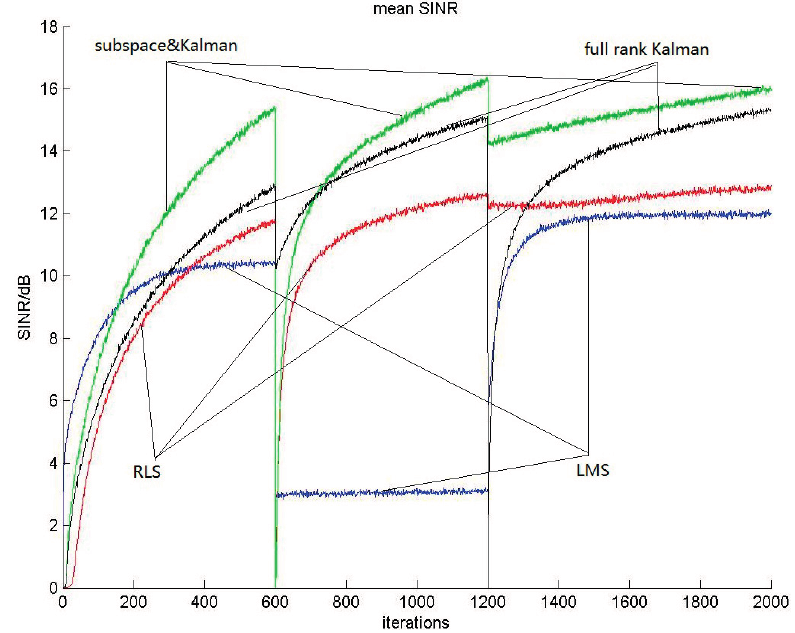
Figure 4. The SINR of all